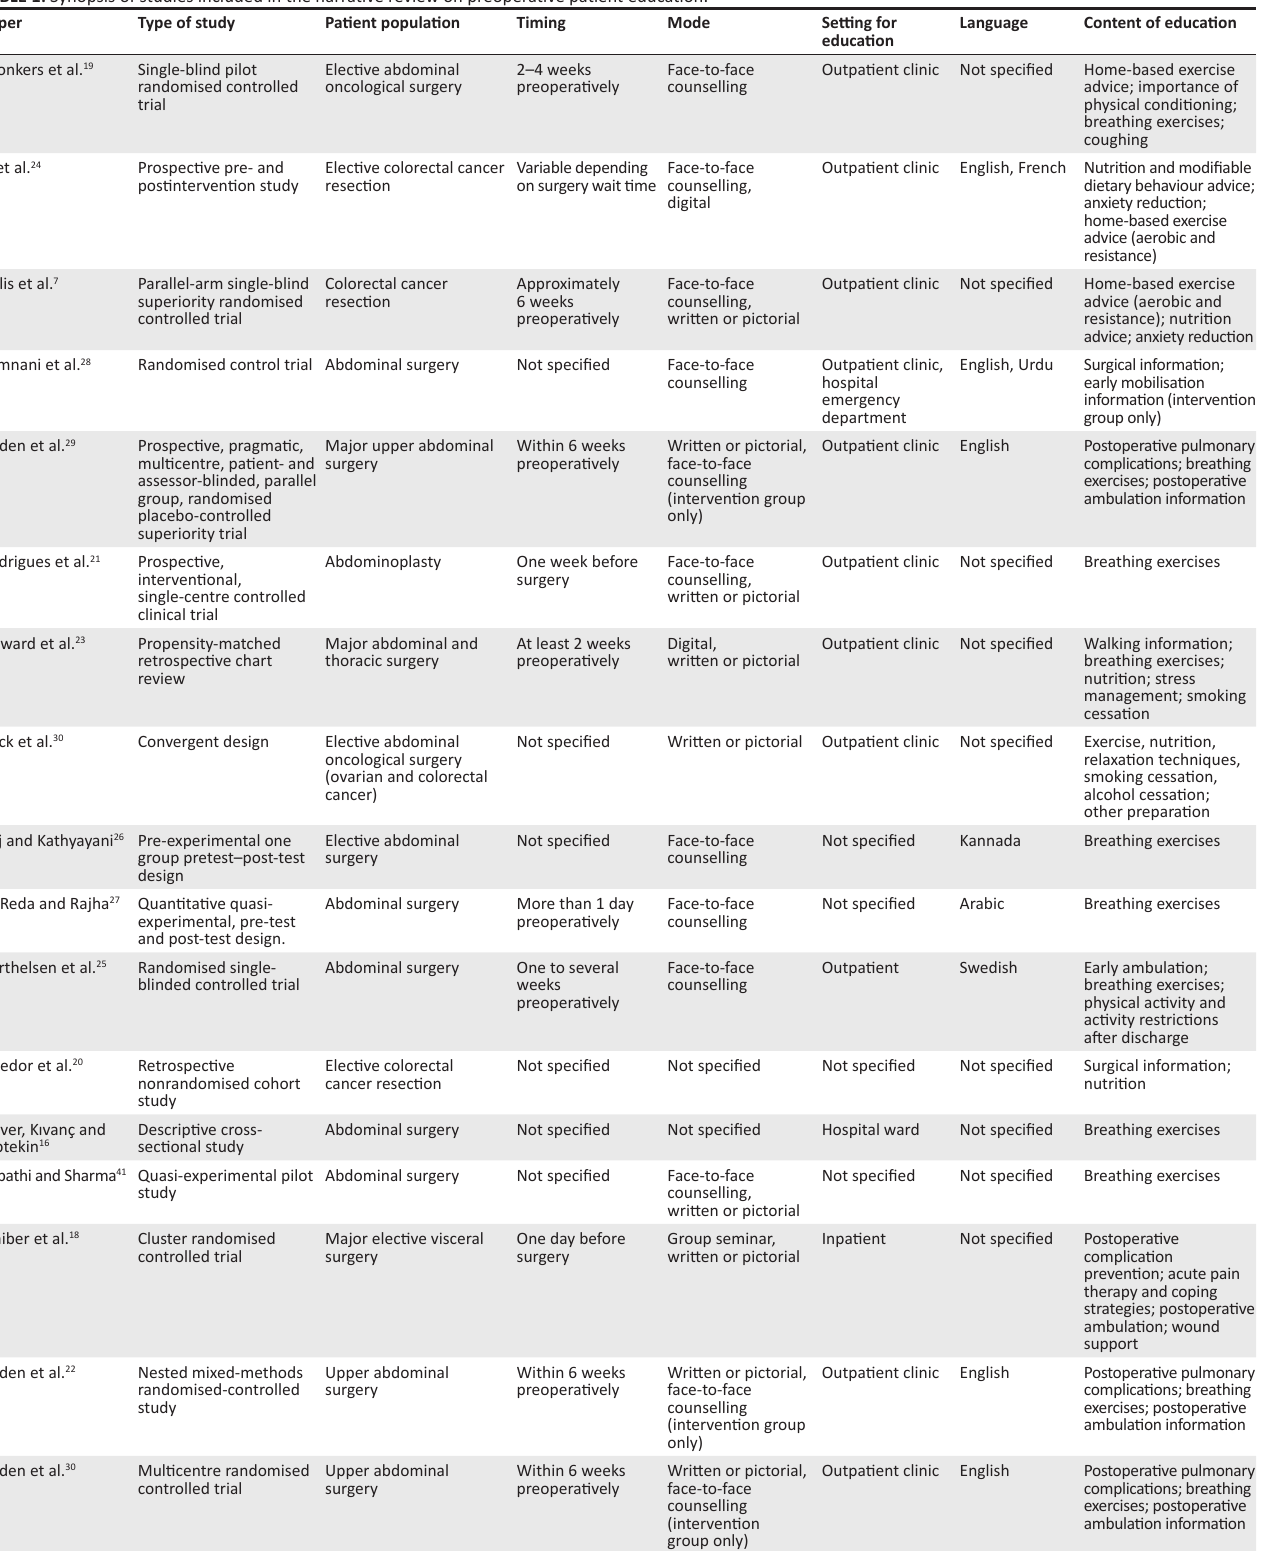
TABLE 1: Synopsis of studies included in the narrative review on preoperative patient education.